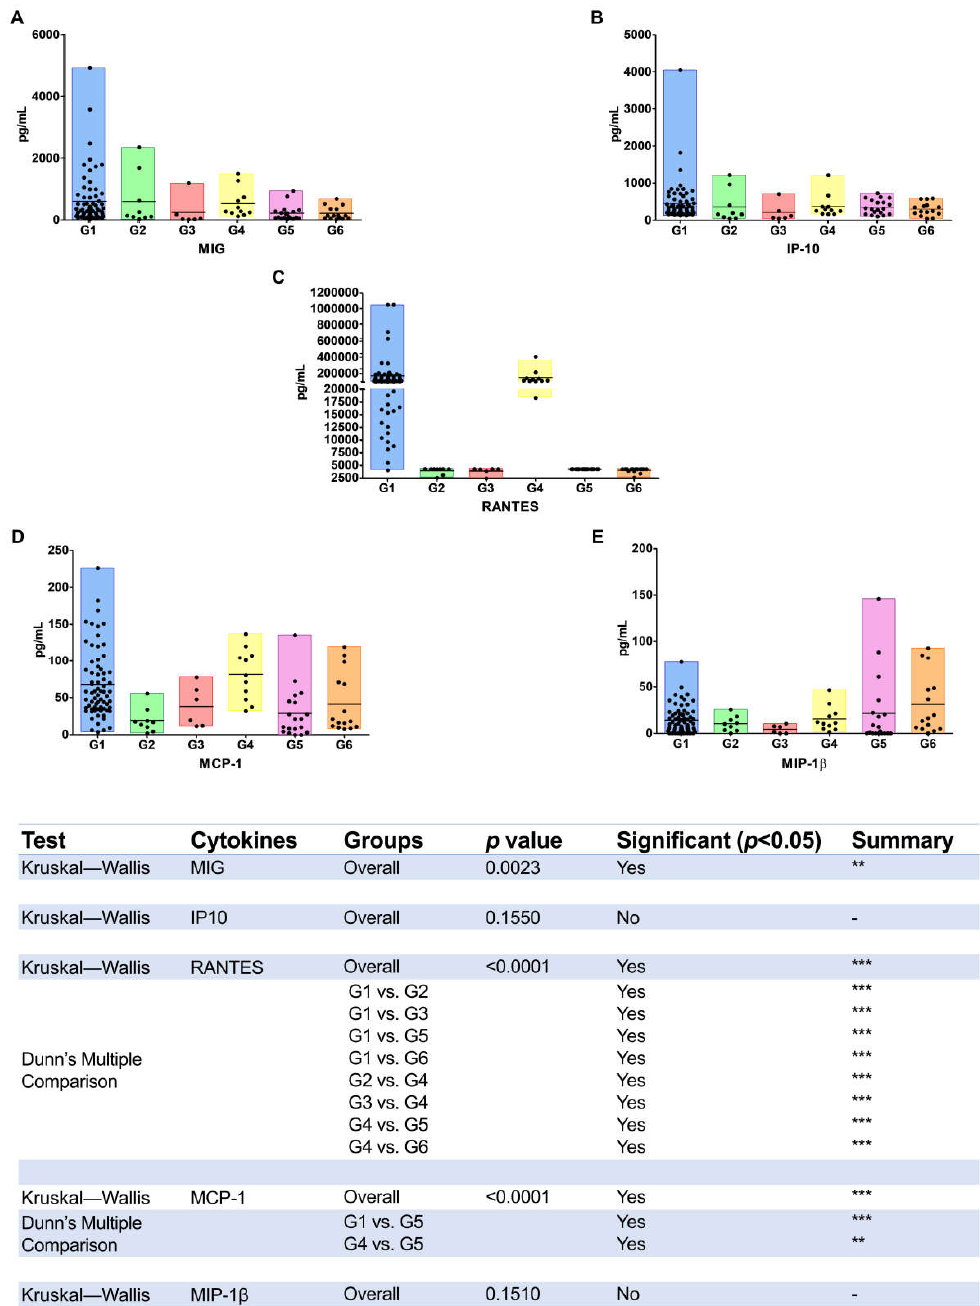
Figure 3. Levels of chemokines detected in plasma samples of HIV-infected and HTLV-1-, HTLV-2-, and/or HCV-co-infected patients. G1 (HIV), G2 (HIV/HTLV-1), G3 (HIV/HTLV-2), G4 (HIV/HCV), G5 (HIV/HCV/HTLV-1), G6 (HIV/HCV/HTLV-2). Subfigures ( A – E ) refer to the values of MIG, IP-10, RANTES, MCP-1 and MIP-1β quantification, respectively. The horizontal line inside the bars denotes mean values. Differences statistically significant are depicted using the Kruskal–Wallis analysis of variance (ANOVA) complemented with Dunn’s multiple comparison test. p -values depicted as asterisks correspond to: ** p ≤ 0.01; *** p ≤ 0.001. Regarding the search for any correlation between the values of CD4, CD8, and HIV VL and the cytokines and chemokines concentrations using the Spearman’s correlation test, a strong positive monotonic correlation between CD4 and CD8 cells counts and IL-6 levels was detected in G2 (CD4, r s = 0.717, p = 0.037; and CD8, r s = 0.655, p = 0.056) and a moderate positive monotonic correlation of CD8 cell numbers and IL-6 in G5 (r s = 0.536, p